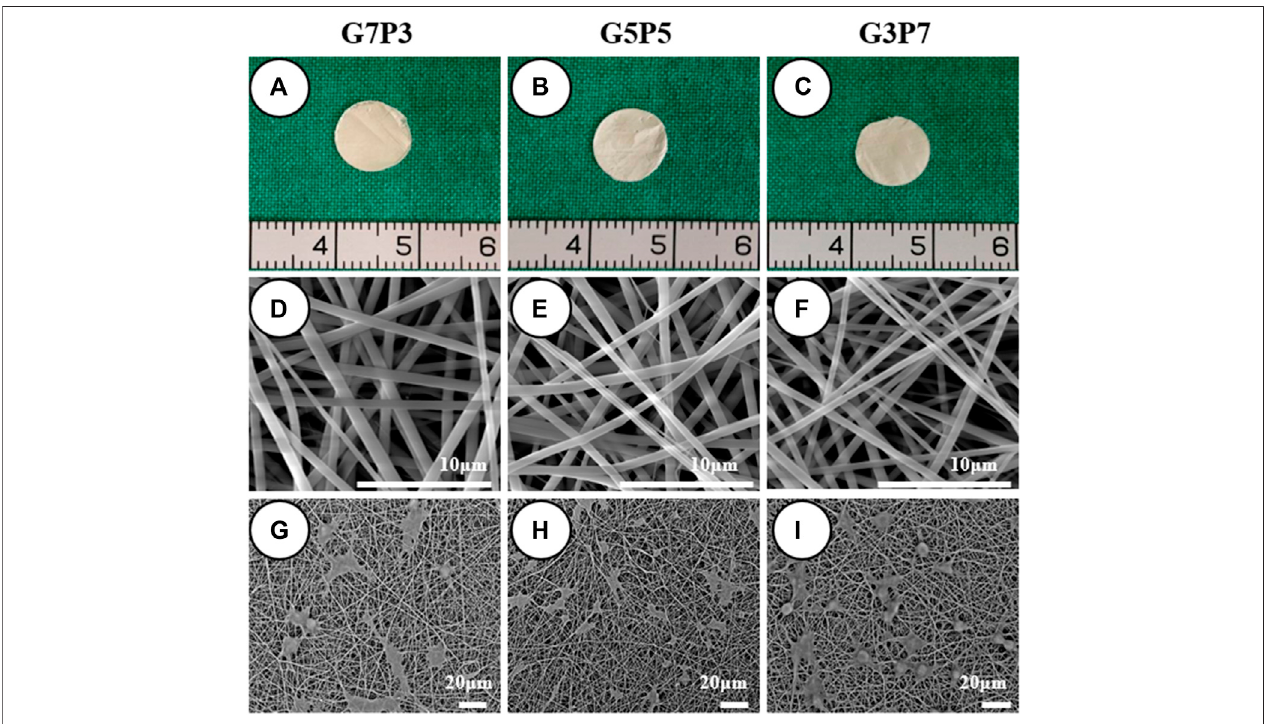
FIGURE 1 | Gross view, microstructure, and cell compatibility of GT/PCL membranes. The membranes are easily trimmed into round shape, and no visible differencesareobservedamongdifferentGT/PCLcontentgroups (A – C) .SEMshowsasimilar fi brousmicrostructurewhilethe fi ber diameterslightlydecreasedwithGT content (D – F), and chondrocytes can spread well on the surfaces of all the membranes after 24 h of cell seeding (G – I) .